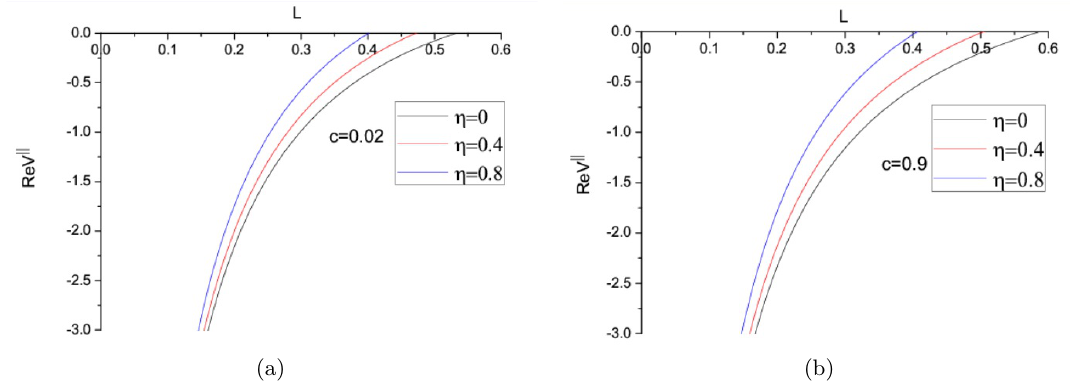
Figure 2 . Re V as a function of L for a Q ¯ Q pair oriented parallel to the axis of the quarks, from Q ¯ Q top to bottom for η = 0 . 8 , 0 . 4 , 0 respectively, T = 200 MeV , in the presence of GC, for a) c = 0 . 02 Ge V 4 and b) c = 0 . 9 Ge V 4